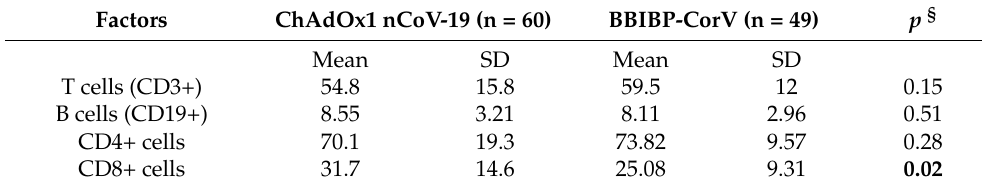
Table 3. Cell-mediated immune response after vaccination (n =